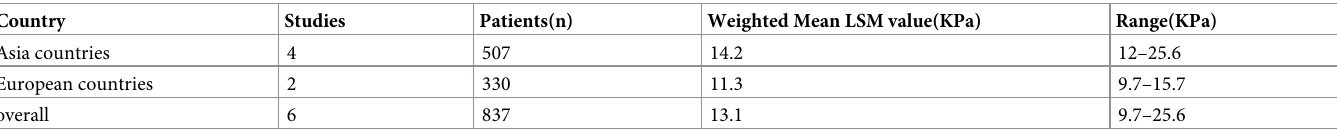
Table 3. Results of optimal LSM cut-off value using TE in predicting postoperative